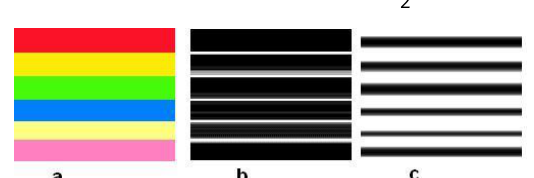
Figure 3. The Impact of standard deviation parameter in the Gabor filter output: (a) Original image, the Gabor filter output with the standard deviation value of: (b) 0.4 and (c) . The values of other Gabor filter generation parameters are as